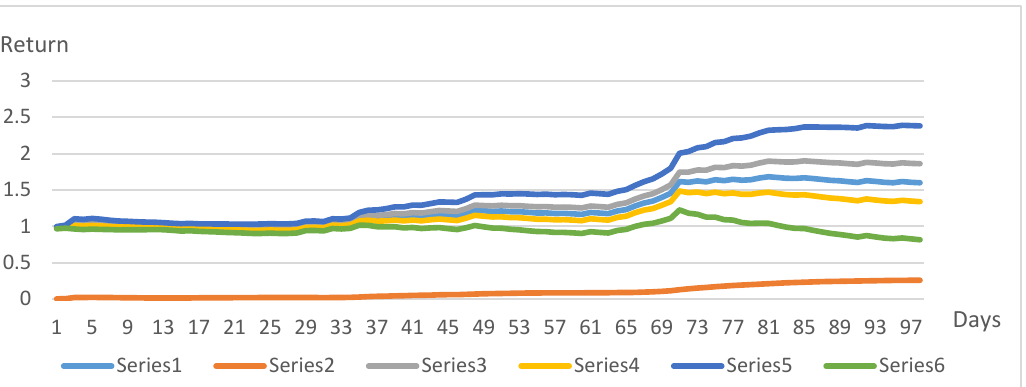
Figure 12. Confidence intervals of return on 7 stocks’ portfolio (UK market) (source: compiled by the authors based on Yahoo Finance data and own calculations).